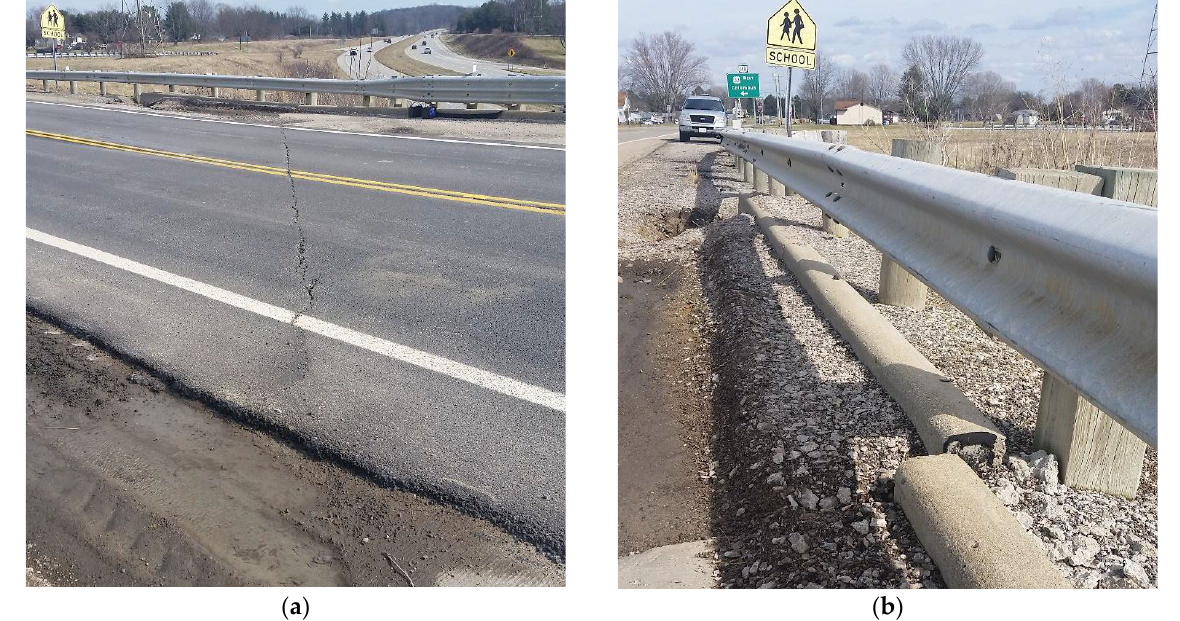
Figure 6. Approach slab deformation ( a ) pavement cracks at end of approach slab and ( b ) bridge curb displacements.